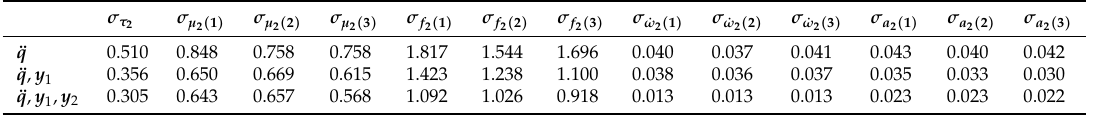
Table 3. Standard deviation of estimated variables for link